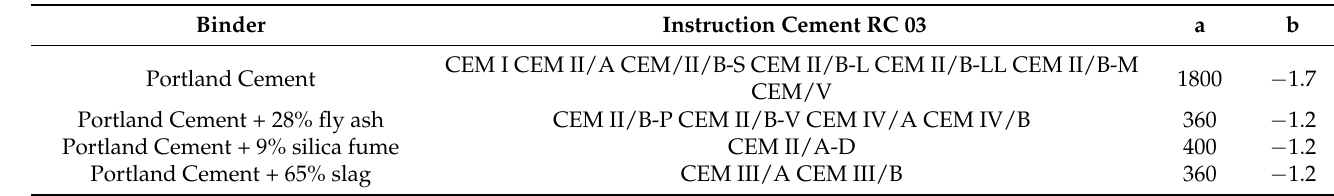
Table 2. Parameters depending on the type of